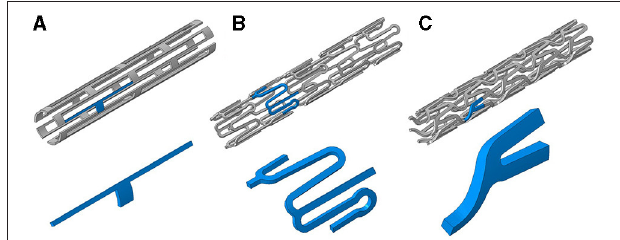
FIGURE 1 | Three stent designs used in this study with inserts (blue highlighted sections) showing representative repeating units within each design: (A) slotted tube, (B) corrugated ring, and (C) delta